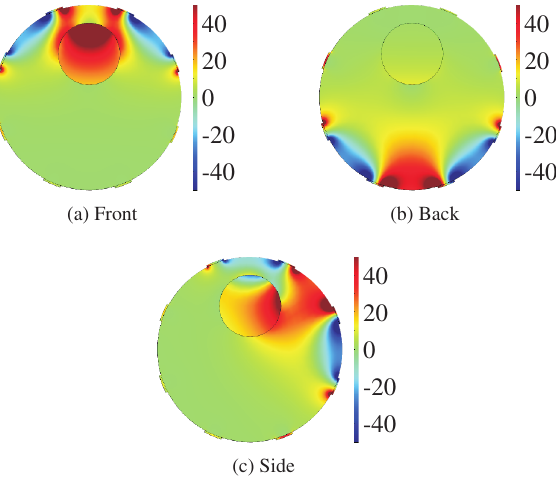
Fig.5: Sensitivity field of the measurement positions showing the spatial difference in sensitivity regions, [ 1 / m 4 ]